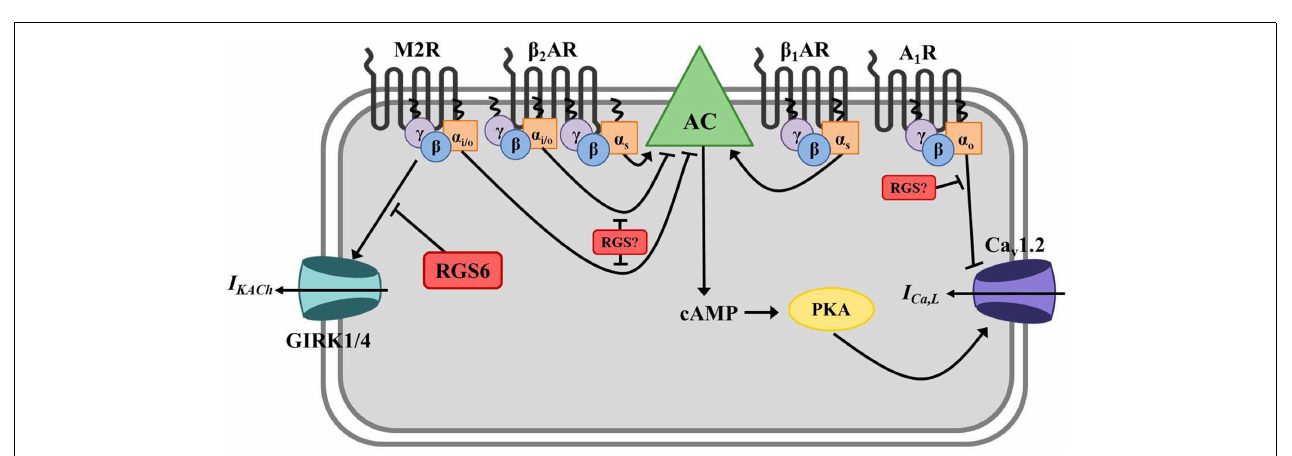
FIGURE 3 | Regulator of G protein signaling-mediated regulation of cardiac automaticity in atrial myocytes. In atrial myocytes, G s -coupled β 1 - or β 2 -adrenergic receptors ( β 1/2 AR) stimulate adenylate cyclase-mediated production of the second messenger cyclic AMP (cAMP), activation of cAMP-dependent protein kinase (PKA), and induction of the calcium current ( I Ca,L ) through L-type calcium channels (primarily Ca v 1.2).The net effect is membrane depolarization, increased cell excitation, and enhanced cardiac contractility. Adenylate cyclase is inhibited by G α i/o -coupled muscarinic M2 receptors (M2R), and activated M2Rs can also directly induce G